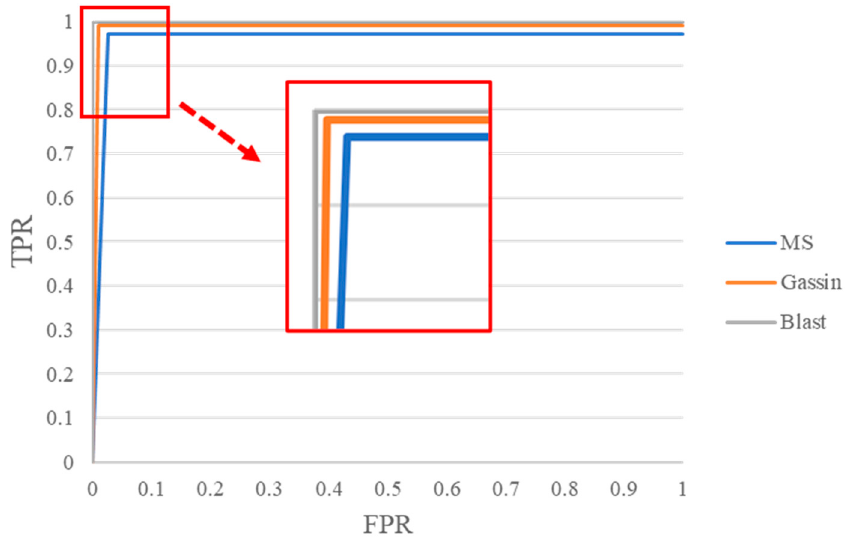
Figure 6. The ROC curve of different classes after applying TFMC to the test dataset. The AUC values of the three classes (MS, Gaussian noise, and Blast) are 0.960, 1, and 0.985, respectively.